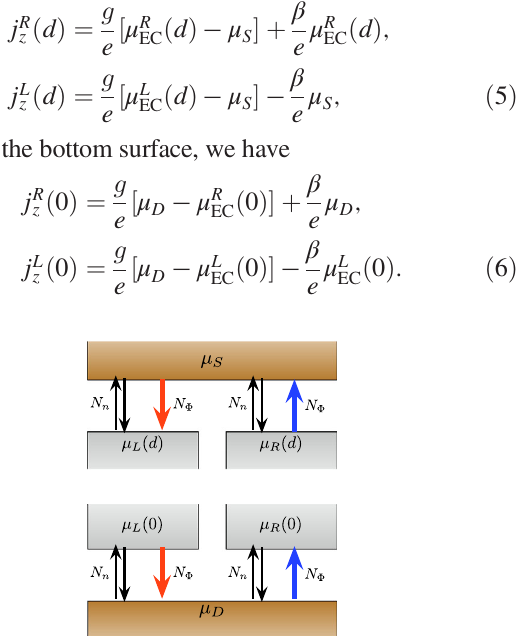
FIG. 3. Landauer description of contact boundary